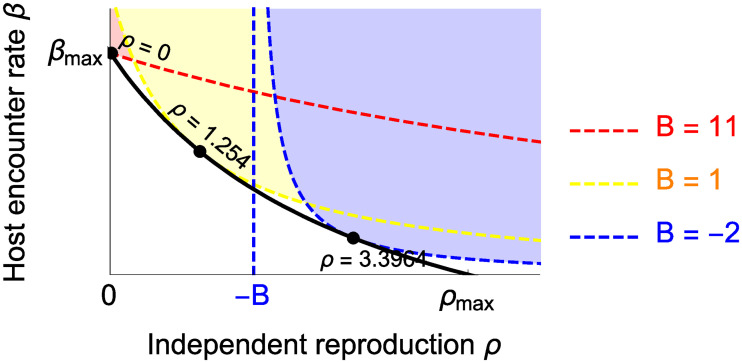
Effect of the compound benefit (B = b − ν + σ) on the ESSs in the case of a concave trade-off curve (black line) under the assumption that the bound reproduction is τ(x) = ρ(x) + b, where b is the bonus reproduction by exploiting the host.Trade-off and host population are as in Fig 3. Dashed lines are the invasion boundaries that separate shaded areas in which mutants can invade and blank areas in which mutants cannot. Black points indicate the ESS values that are corresponded with different values of B. Other parameters: c = 2, N = 100, μ0 = 3, ω = 6.5, βmax = 5, α = 3.1, δ = 1.3, σ = 0.